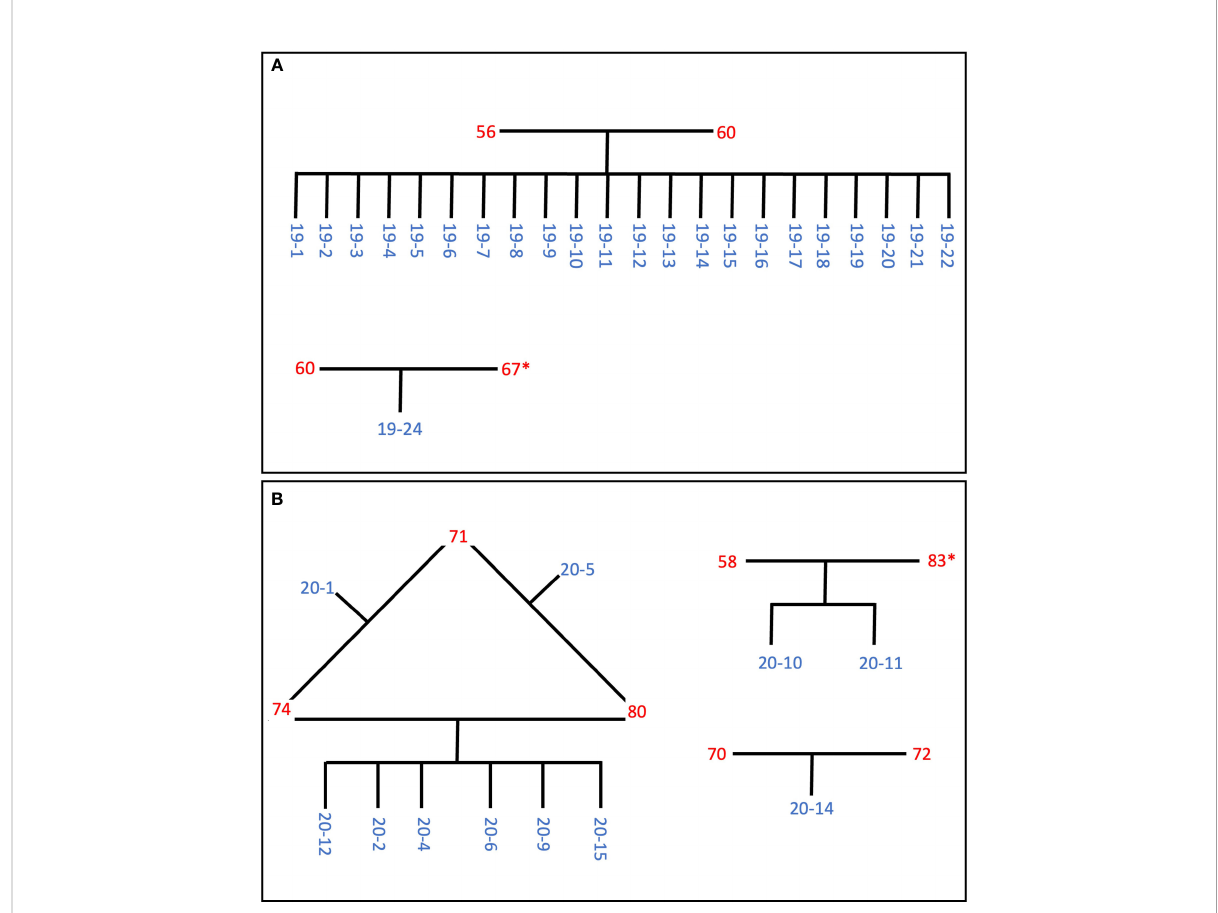
FIGURE 3 Inferred pedigrees of the parents (red) and offspring (blue) for (A) the 2019 cohort and (B) the 2020 cohort, based on identity-by-descent probabilities (Supplementary Table 2) and spawn dates (Table 1). Colonies with an asterisk were not sequenced, but were inferred to be the parent based on their spawn date and an offspring ’ s lack of IBD probability of ~0.5 to more than one